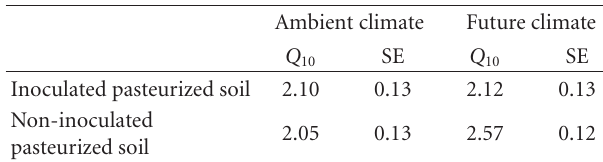
Table 2: Weighted mean Q 10 (weighted using 1/(SE of Q 10 )) and one standard error (SE) on WM for the di ff erent treatments. The Q 10 was calculated by fitting (1) to the